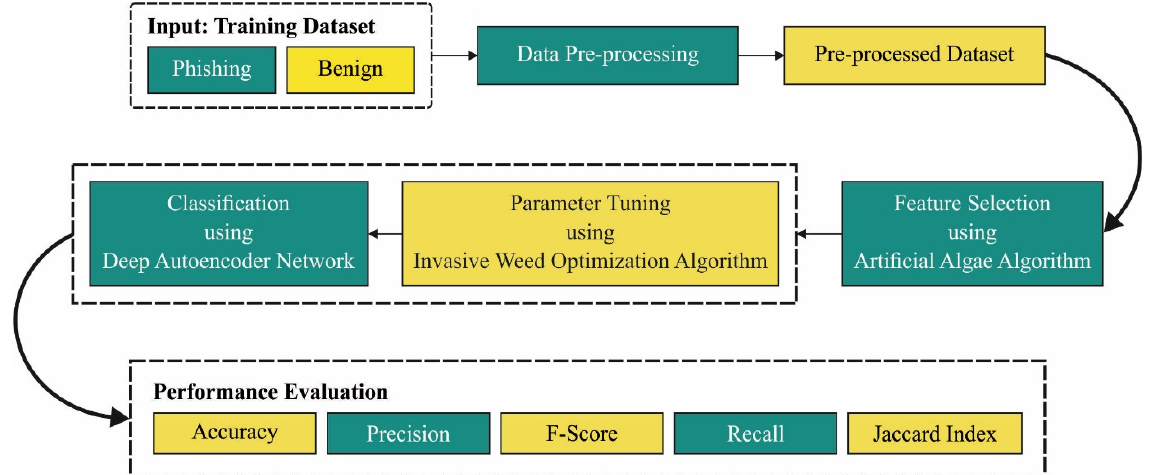
Figure 1. Block diagram of ODAE ‐ WPDC approach.